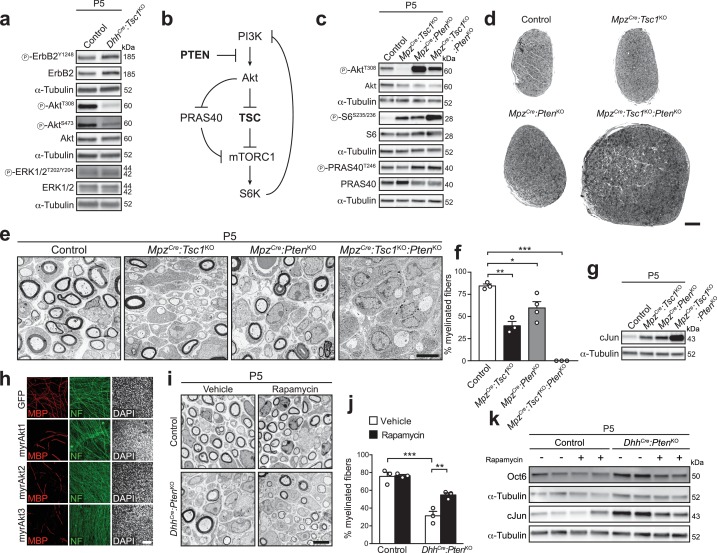
Deletion of PTEN restores Akt activity, but does not rescue the differentiation delay in TSC1-mutant mice.(a) Western blot analysis, P5 sciatic nerve lysates from control and DhhCre:Tsc1KO mice (n = 3 mice/genotype). Quantification: Figure 2—figure supplement 1a. (b) Scheme of roles of PTEN and the TSC complex within the PI3K-Akt-mTORC1 axis. (c) Western blot analysis, P5 sciatic nerve lysates from control, MpzCre:Tsc1KO, MpzCre:PtenKO, and MpzCre:Tsc1KO:PtenKO mice (n = 3 mice/genotype). Quantification: Figure 2—figure supplement 1b. (d) Semithin cross sections of P5 control and mutant sciatic nerves (n = 3 mice/genotype). Scale bar: 100 μm. (e) Electron micrographs of P5 control and mutant sciatic nerves (n = 3 mice/genotype). Scale bar: 4 μm, refers to whole panel. (f) Myelinated fibers relative to all sorted fibers. Bar height: Mean; error bars: s.e.m. (n = 3 controls, TSC1-mutants, double-mutants and n = 4 PTEN-mutants, one-way ANOVA with Tukey’s multiple comparisons test, F(3,9) = 44.98, p<0.0001; pcontrol vs TSC1KO = 0.001, pcontrol vs PTENKO = 0.028, pcontrol vs doubleKO <0.0001). At least 150 sorted fibers per sample were counted (random EM fields). (g) Western blot analysis, P5 sciatic nerve lysates from controls and mutants (n = 3 mice/genotype). Quantification: Figure 2—figure supplement 1c. (h) Immunostainings of DRG-explant cultures infected with GFP- or Akt-expressing lentiviruses at day in vitro (DIV) 3. Quantification: Figure 2—figure supplement 2e. Three independent experiments performed, one representative experiment shown. MBP: myelin basic protein. NF: neurofilament. Scale bar: 100 μm, refers to whole panel. (i) Electron micrographs of P5 sciatic nerves from control and DhhCre:PtenKO mice treated with vehicle or rapamycin (n = 3 mice/condition). Scale bar: 4 μm, refers to whole panel. (j) Quantification referring to i. Myelinated fibers relative to all sorted fibers. At least 150 sorted fibers per sample were counted (random EM fields). Bar height: Mean; error bars: s.e.m. (n = 3 mice/condition, two-way ANOVA with Tukey’s multiple comparisons test, F(1,8) = 9.485, p=0.0151; pcontrol vs KO vehicle = 0.0001, pKO vehicle vs rapamycin = 0.0085). (k) Western blot analysis, P5 sciatic nerve lysates from controls and mutants treated with vehicle or rapamycin (n = 4 mice/condition). Quantification: Figure 2—figure supplement 1d. *p<0.05, **p<0.01, ***p<0.001.